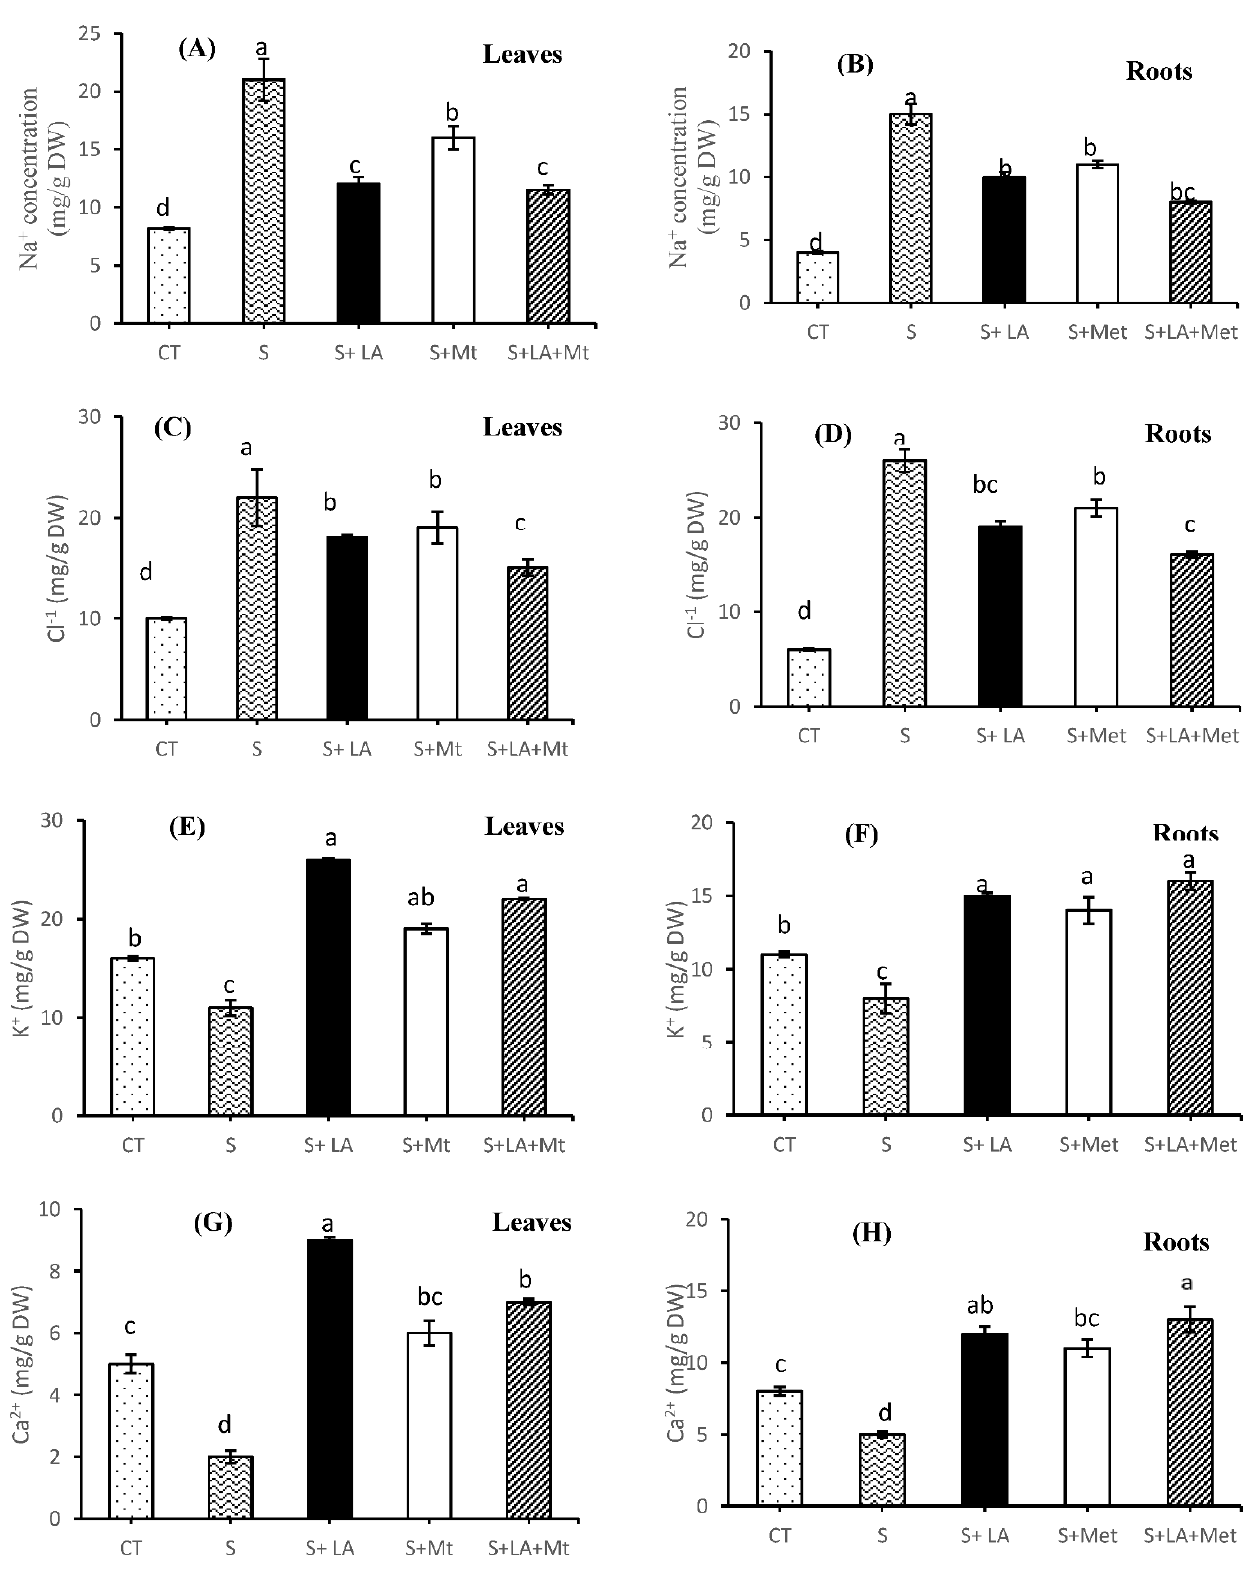
Figure 4. The effect of lipoic acid (LA), melatonin (MT), and their combination (LA + MT) under salt stress on Na + concentration in leaves ( A ) and roots ( B ), Cl − 1 concentration in leaves ( C ) and roots ( D ), K + concentration in leaves ( E ) and roots ( F ) and Ca +2 concentration in leaves ( G ) and roots ( H ) of Brassica napus L. seedlings exposed to salinity (100 mM NaCl) for 30 days. Abbreviations are given in the Figure 1. Error bars on each column show the ± SE of three replication samples. Different letters on each bar indicate a significant difference according to LSD test ( p ≤ 0.05).